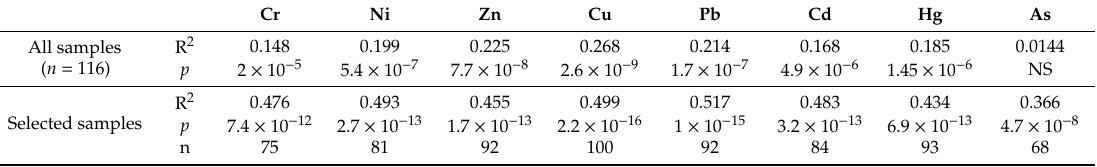
Table 2. p and R 2 values of the relationships between the metal concentrations and Oligochaete index of sediment bioindication (IOBS) with all samples ( n = 116) and without the samples showing both a biological e ff ect (IOBS < 3) and a concentration of metal < 2-fold the background concentration (Selected samples; n = 68–100 depending on the